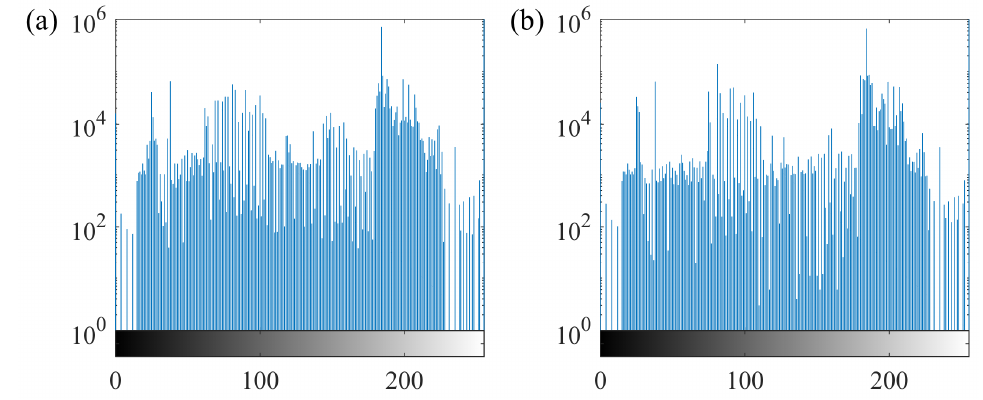
Figure 7. Histogram of the gray value: ( a ) initial model; ( b ) mesh-mapped model. The calculated cosine value was 0.99723, and the vector angle was 4.2663 ◦ . This indicates that the model before and after the mesh mapping was remarkably comparable, proving the mesh mapping method proposed in this